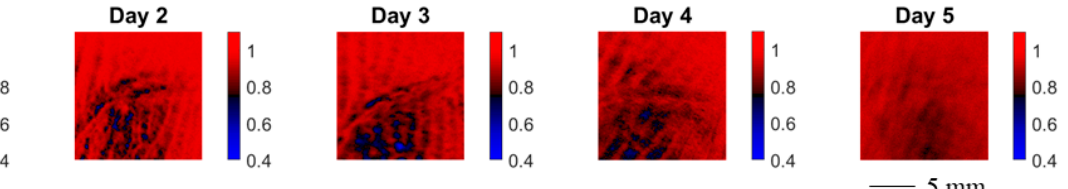
7 of 11 Figure 7. Threshold polarization stain image for a contracture scar ( left ) and a hypertrophic scar ( right ). The scarred portions can easily be identified. Near the margins of the image, the values